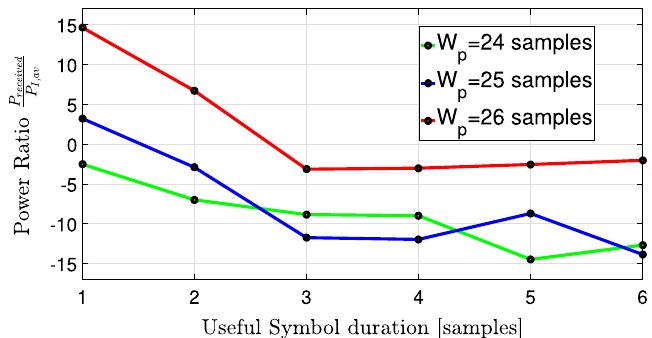
Fig. 14 Investigation of possible ADC saturation for the first few samples of the three smallest (cid:31) CP , i.e., 6 with acceptable SINR, i.e., (cid:31) CP W p 24,25,26 and L o = = { }